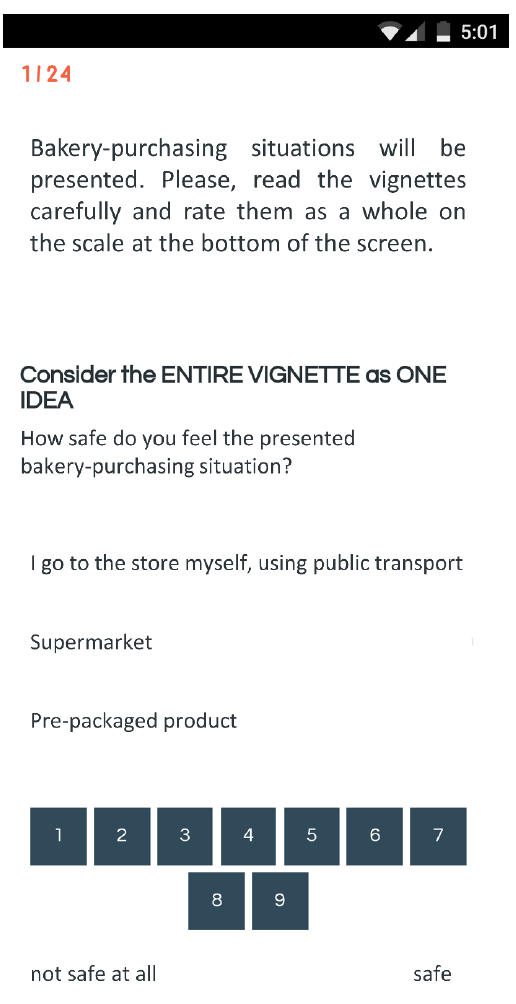
Figure 1. Example vignette used in the study.